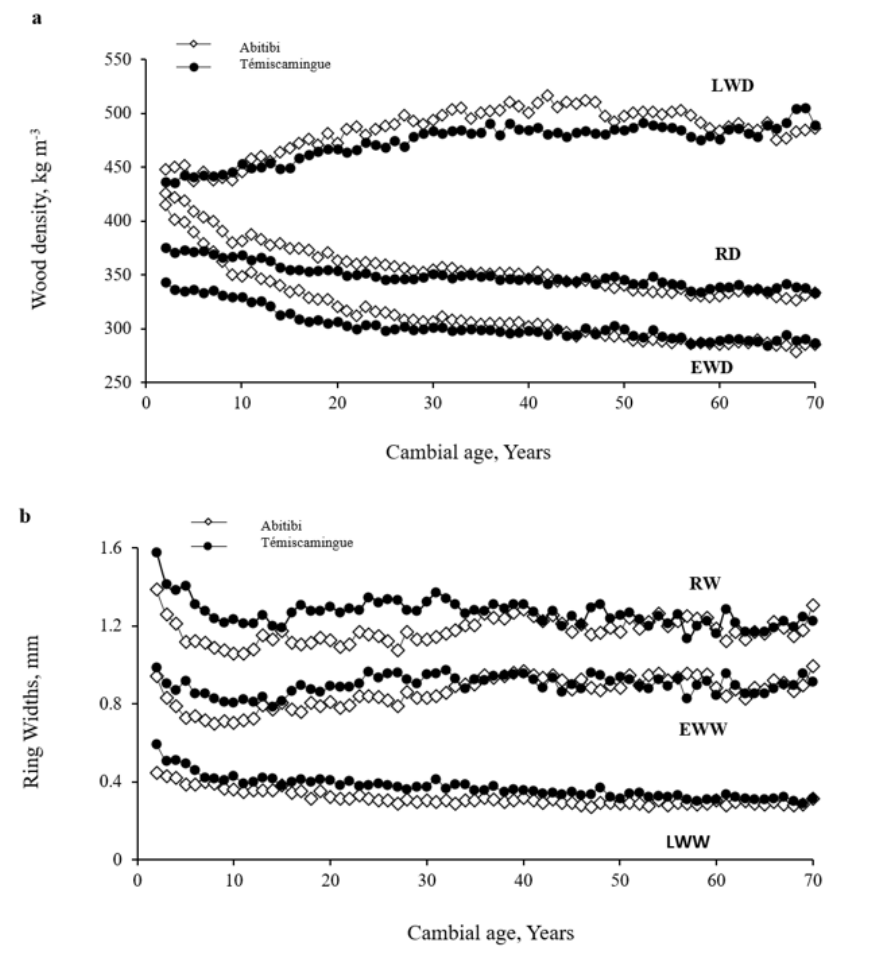
Figure 3. Regional variation in ( a ) annual ring density (RD, kg m − 3 ), earlywood density (EWD, kg m − 3 ), latewood density (LWD, kg m − 3 ), ( b ) ring width (RW, mm), earlywood width (EWW, mm) and latewood width (LWW, mm) in Thuja occidentalis in the Abitibi-Témiscamingue, Quebec, Canada. Table 3. Regional comparison of ring density components and ring widths for the whole tree and juvenile and mature wood at breast height in Thuja occidentalis in the Abitibi-Témiscamingue, Que- bec, Canada.